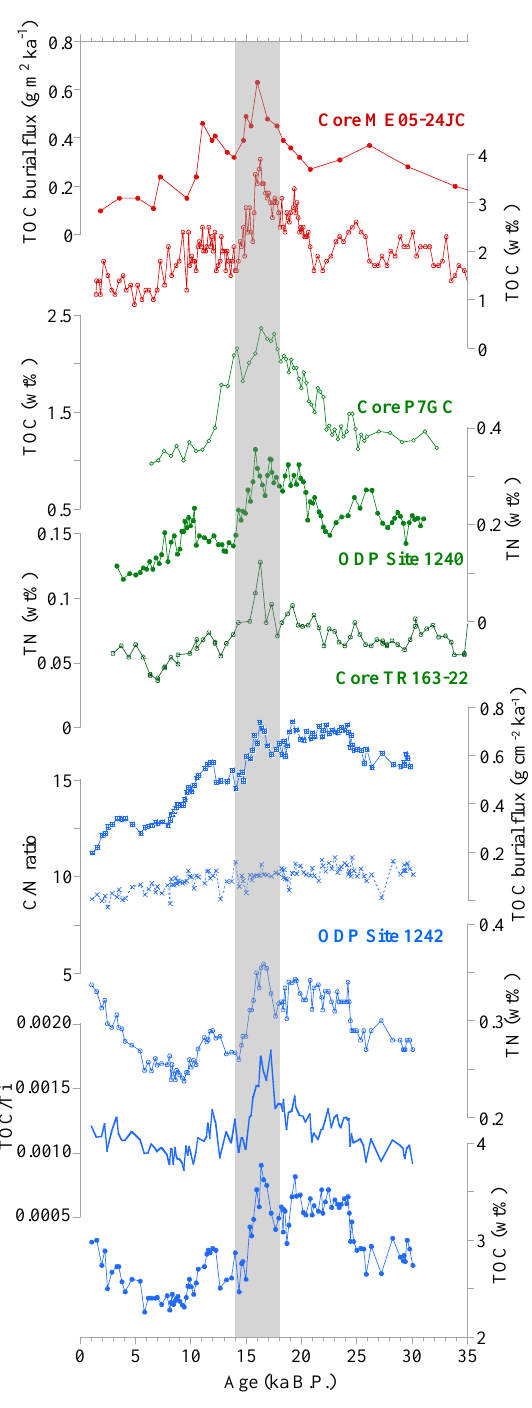
Fig. 2. Downcore profiles of TOC/Ti, TOC (wt%) and TN (wt%) contents, of C/N ratio, and of burial fluxes of TOC (in gcm 2 ka − 1 ) at ODP Site 1242 (in blue). Downcore profiles of TOC (wt%), TN (wt%), and TOC burial fluxes for additional sites (in green and blue) referred in the text and localized in Fig. 1. The shaded area highlights the interval of organic export maximum in the Eastern Equatorial Pacific during the